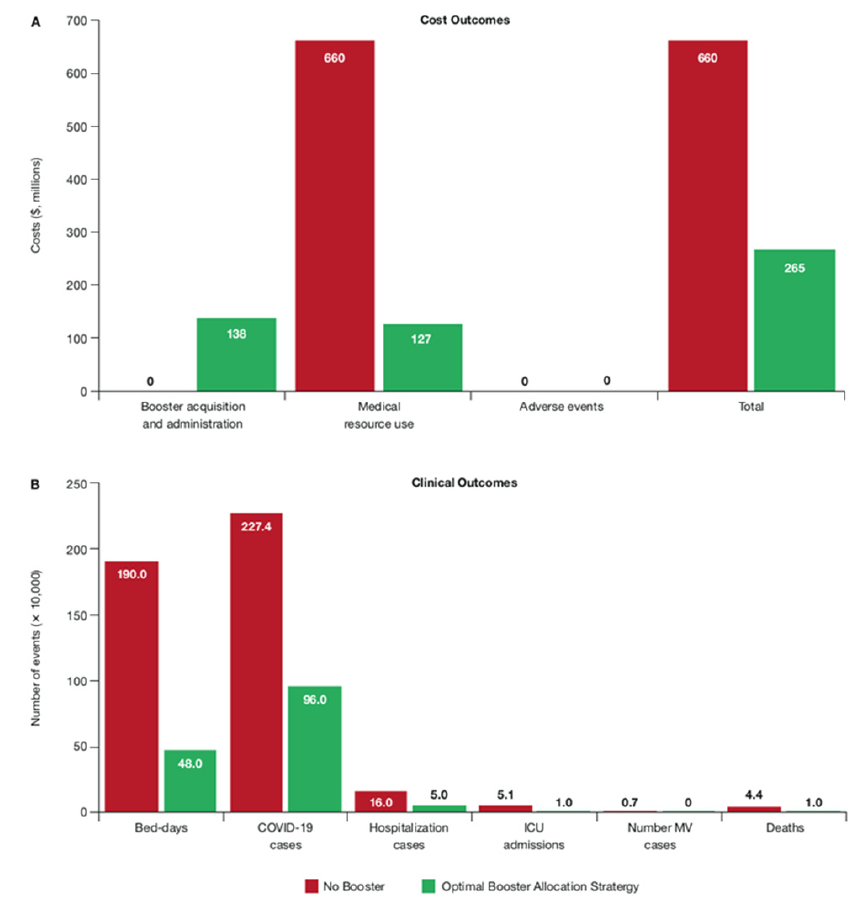
Figure 3. Cost ( A ) and clinical ( B ) outcomes with the Best BAS in Brazil (base-case country).